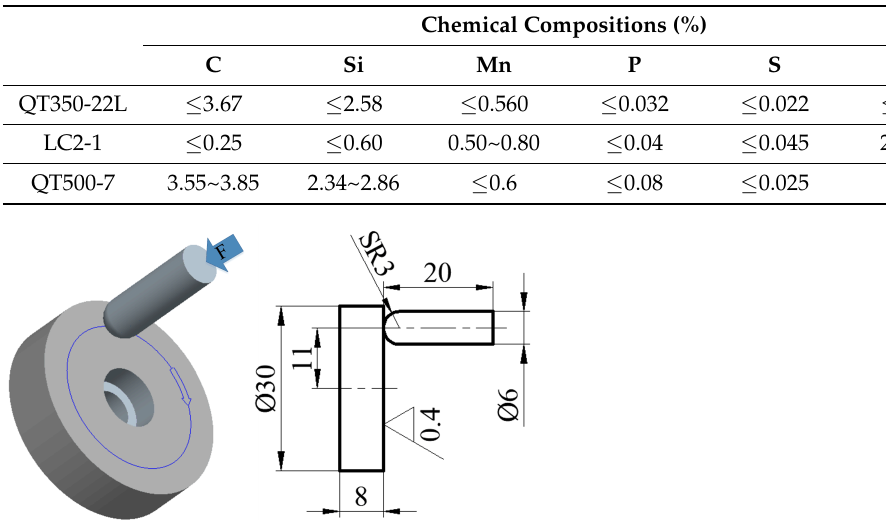
Table 1. Chemical compositions of pin and disc samples.